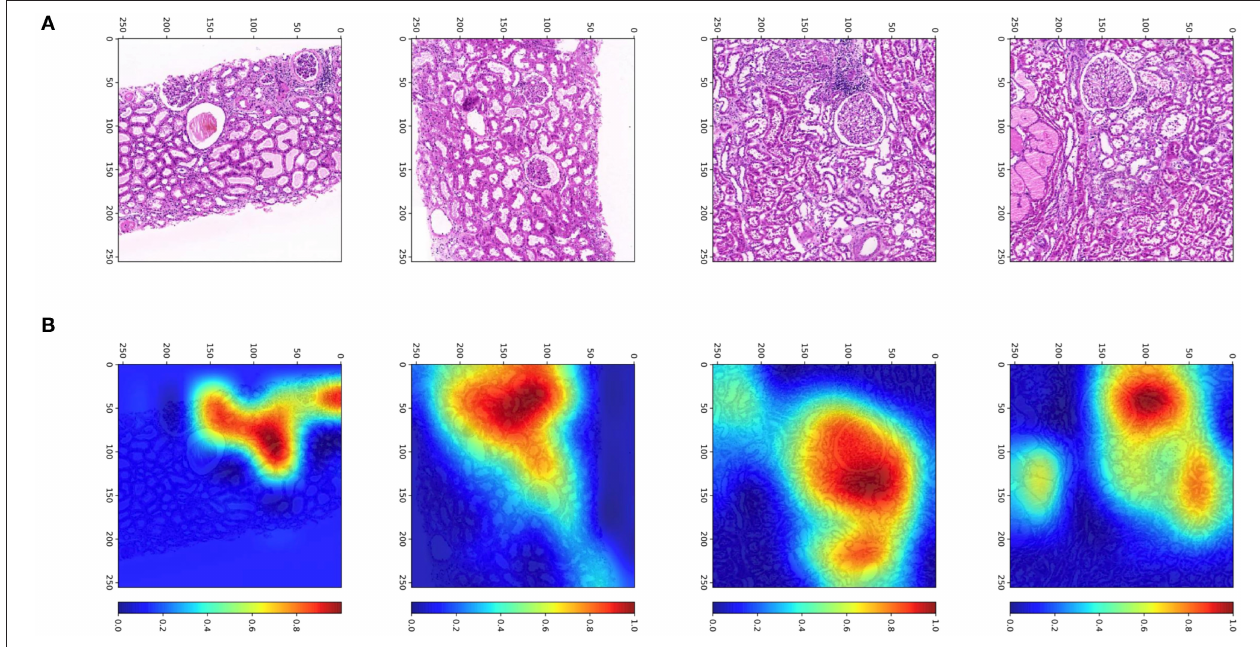
FIGURE 7 | Patches and heatmap of RGF. (A) Patches from WSIs at × 200, resized to 256 pixels; (B) the corresponding gradient-weighted class activation mapping (Grad-CAM) heatmap, with red areas showing discriminative features for